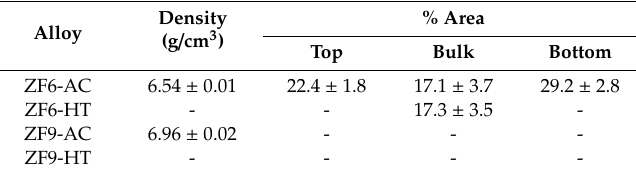
Density and % areas of Nb ss in as cast (AC) and heat treated (HT) alloys